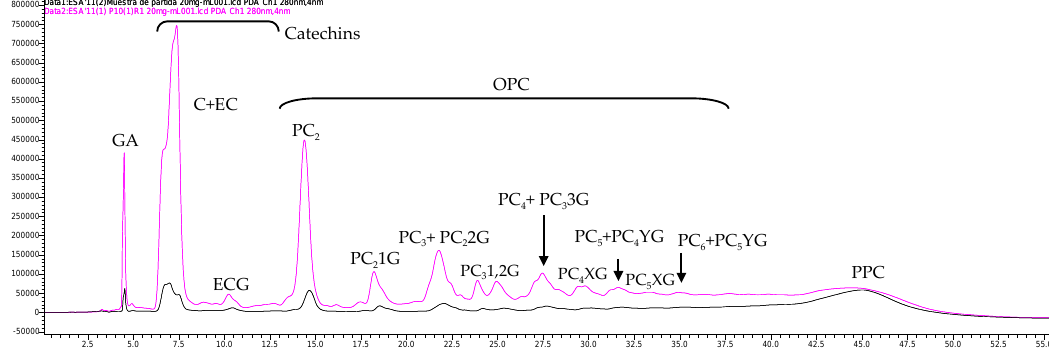
Figure 8. Overlay of NP–HPLC–PAD chromatograms (280 nm) of 20 mg / mL reconstituted initial (clarified) grape seed extract (GSE; black) and 20 mg / mL reconstituted OPC-rich fraction (after UF and SPE 1 ) (magenta) acquired at 280 nm. GA—gallic acid, C + EC—catechin and epicatechin, ECG—epicatechin gallate, PC 2 to PC 6 —procyanidin dimers to hexamers, PC 2 1Gmonogaloylated procyanidin dimer, PC 2 2G—digaloylated procyanidin dimer, PC 3 1,2G—mono- and digaloylated procyanidin trimers, PC 3 3G—trigaloylated procyanidin trimer, PC 4 XG and PC 5 XG—galoylated procyanidin tetramers and pentamers of low degree of galloylation, PC 4 YG and PC 5 YG—galoylated procyanidin tetramers and pentamers of high degree of galloylation, OPC—oligomeric procyanidins, PPC—polymeric procyanidins. Table 2. Flavan-3-ol enrichment (by groups) in purified OPC fractions after UF and after each of the four consecutive SPE batches.